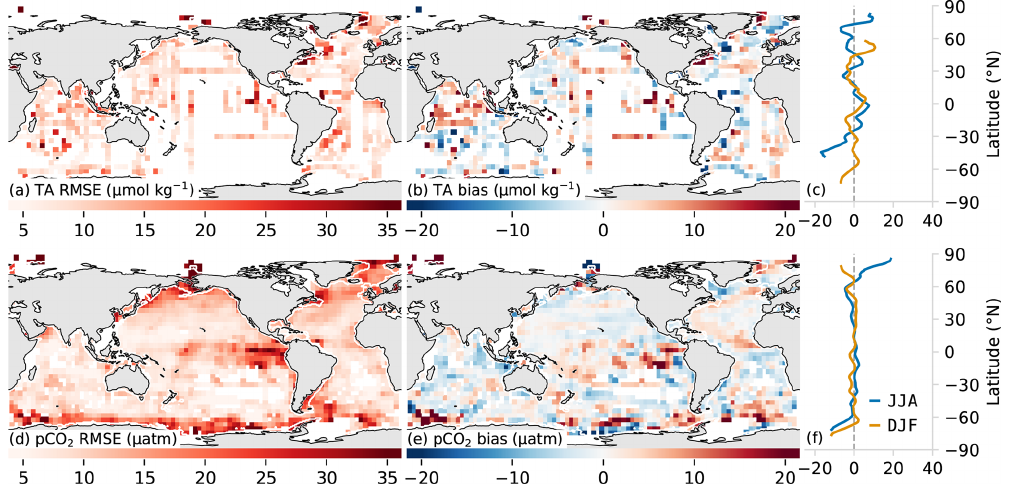
Figure 3. Test metrics for total alkalinity (a, b) and p CO 2 (c, d) . The left-hand column (a, d) shows the root mean squared error (RMSE) compared with the target data. Similarly, the middle column (b, e) shows bias compared to the respective training data sets (GLODAP v2.2019 and SOCAT v2019). The right-hand column shows the zonally averaged biases for June, July, and August (JJA, blue) and December, January, and February (DJF, orange). A 2D spatial convolution was first applied to the 1 ◦ × 1 ◦ pixels to make regional patterns in the biases and RMSE clearer, and data were then aggregated into 4 ◦ × 4 ◦ pixels for clearer visualization.